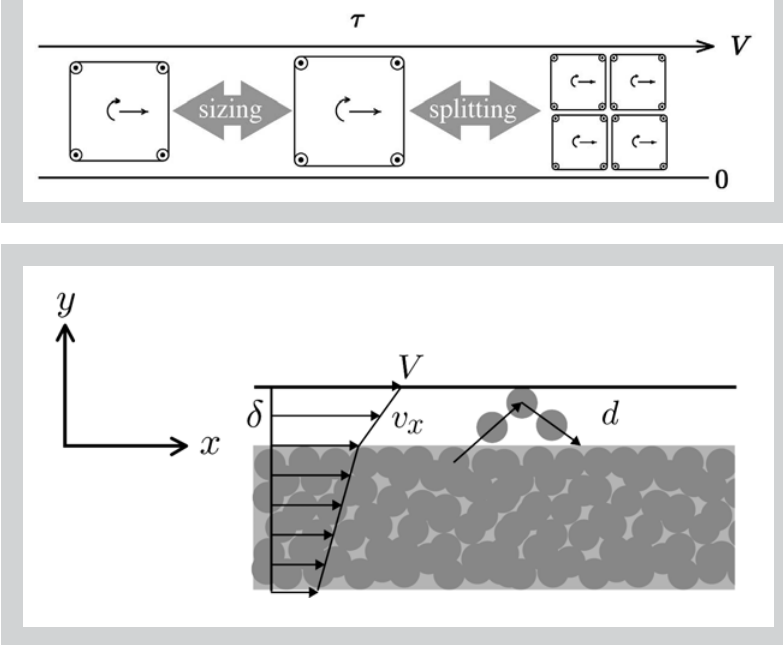
Figure 2: a) Modules and the size change in the module sus- pension theory. b) Inertial